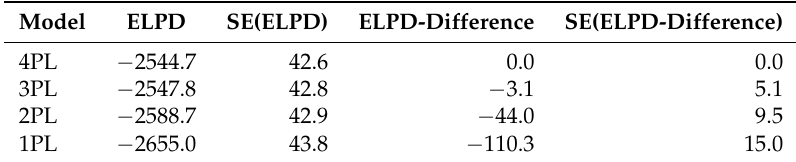
Table 1. Bayesian Model comparison based on the leave-one-out cross-validation.